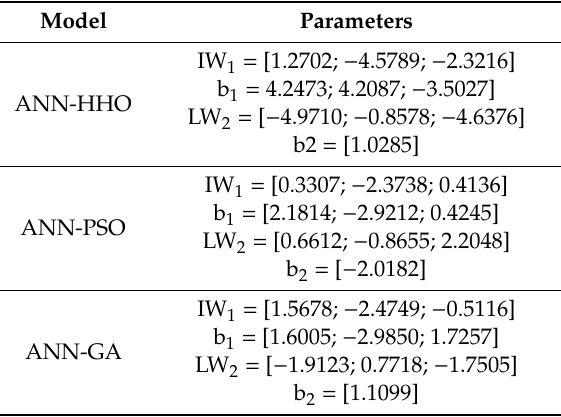
Table 3. Optimal ANN parameters using HHO, PSO and GA algorithms.